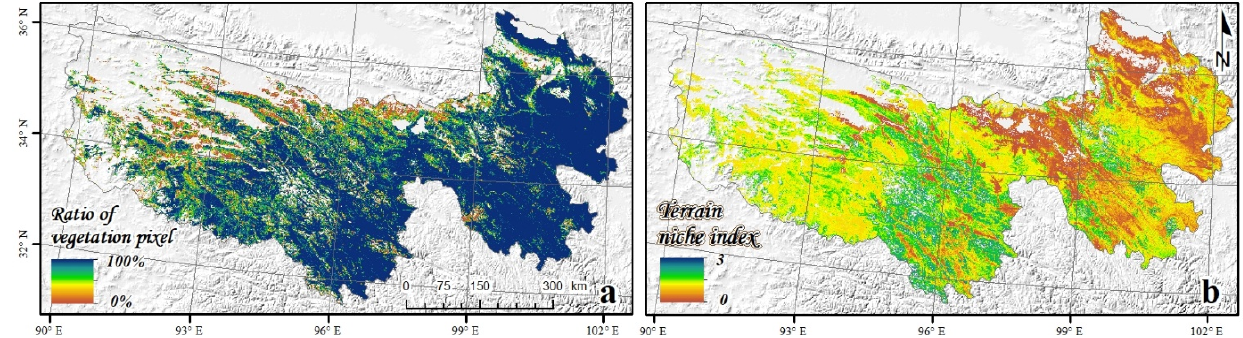
Figure 3. Ancillary data: ( a ) Pixel ratio map of vegetation; ( b ) Terrain niche index.